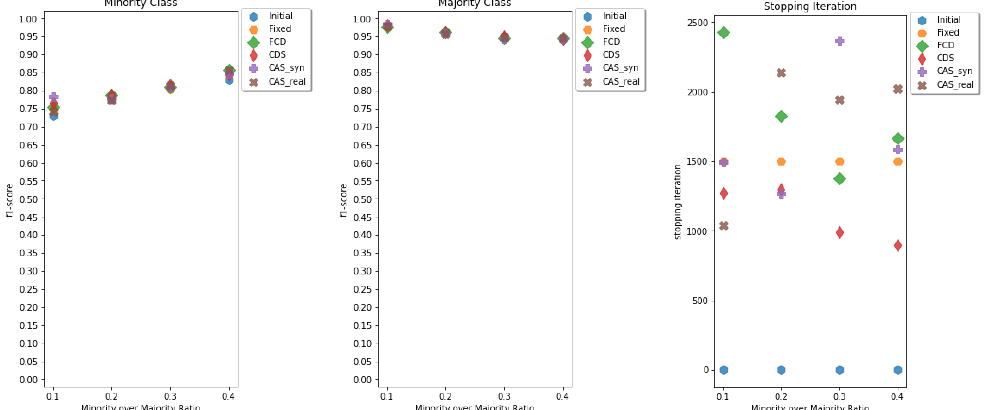
Figure 14. Average F1 results of iscx_defacement-based datasets by imbalance ratio for minority ( left ) and majority ( center ) classes, and average number of iterations until the training is stopped ( right ).